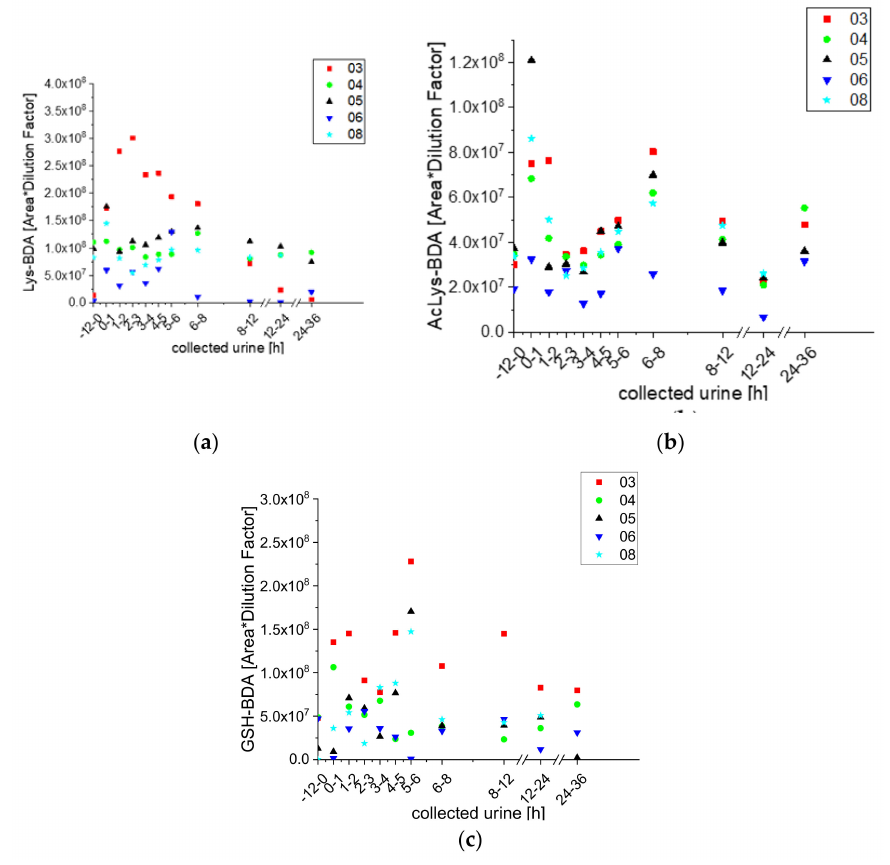
Figure 2. Excretion kinetics of Lys-BDA ( a ), AcLys-BDA ( b ), and GSH-BDA ( c ): UPLC-qToF-MS / MS measurements (as detailed in Materials and Methods) of contents in samples of urine from participants three, four, five, six, and eight at indicated times after co ff ee consumption (h). Excretion kinetics of Lys-BDA, AcLys-BDA, and GSH-BDA measured by UPLC-qToF (details see Materials and Methods section) over 36 h after co ff ee consumption. Shown are the individual kinetics of the participants three, four, five, six, and eight. The measurements were performed as triplicates and the data points are shown as mean values with standard deviation.